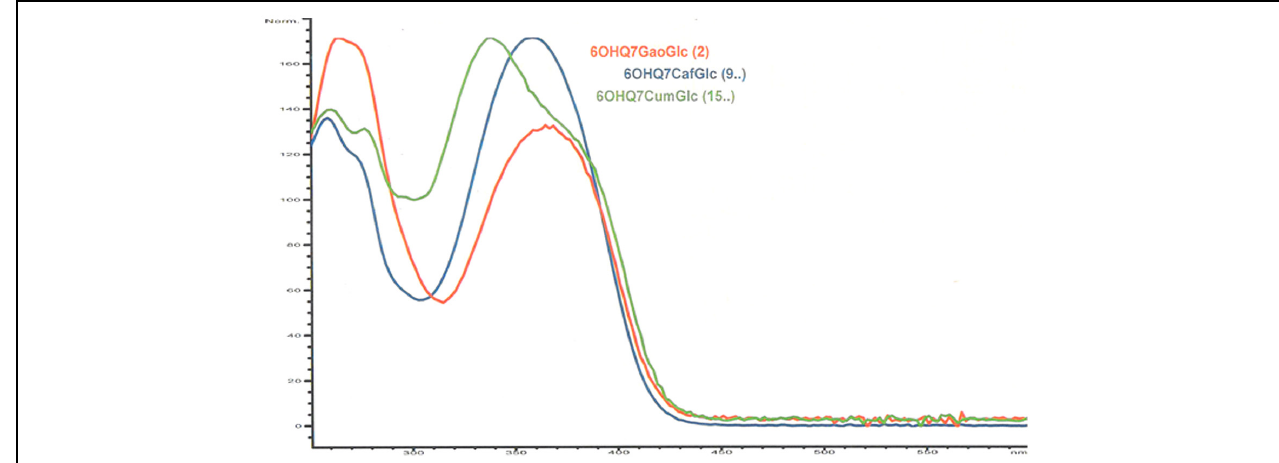
FIGURE 2 | UV spectra of 2, 9, and 15 recorded on-line during HPLC